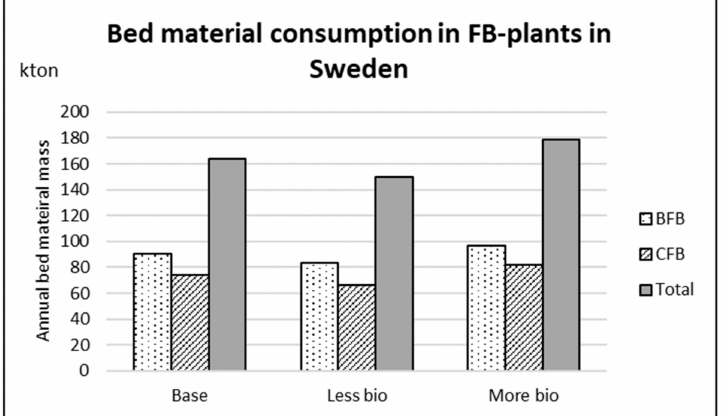
Figure 4. Estimated amounts of sand consumed annually as bed material in BFB and CFB boilers in Sweden for three different assumptions about biomass combustion.